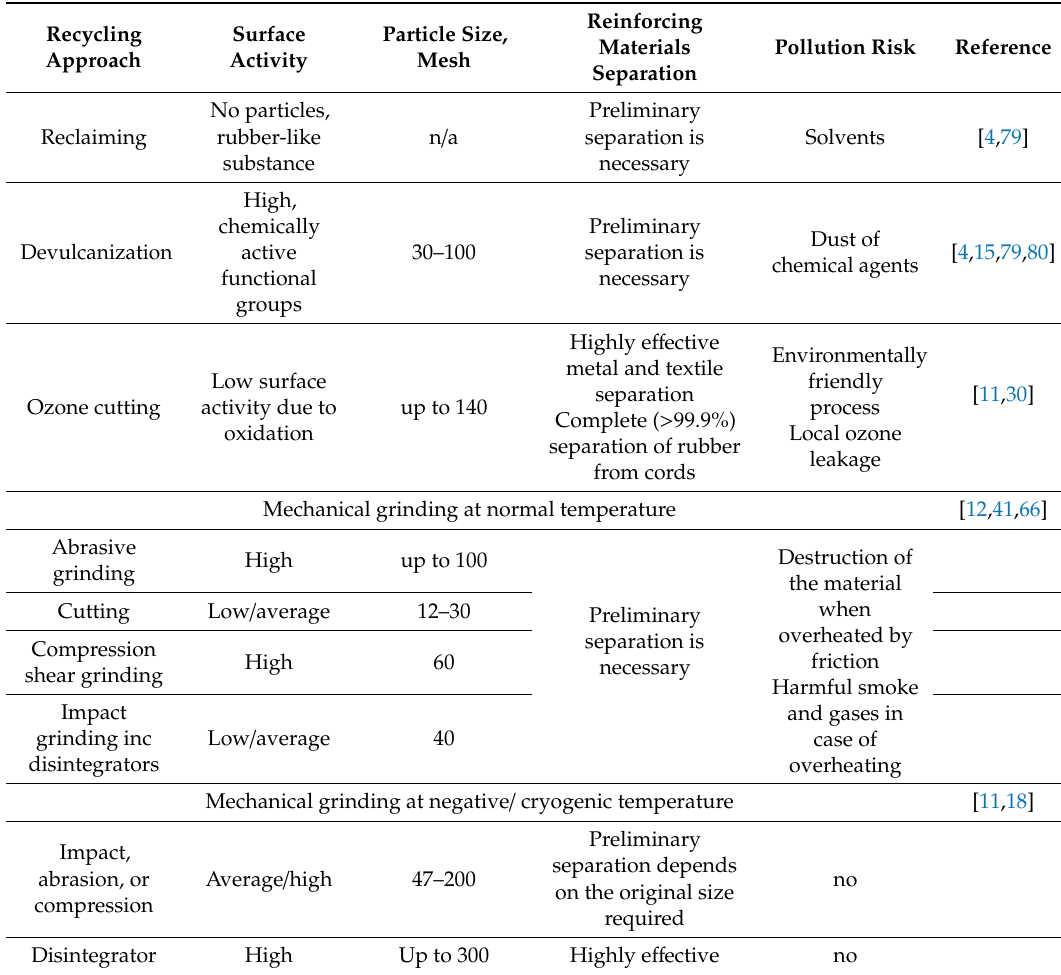
Table 4. Overview of waste rubber recycling approaches, crumb rubber properties, and associated environmental